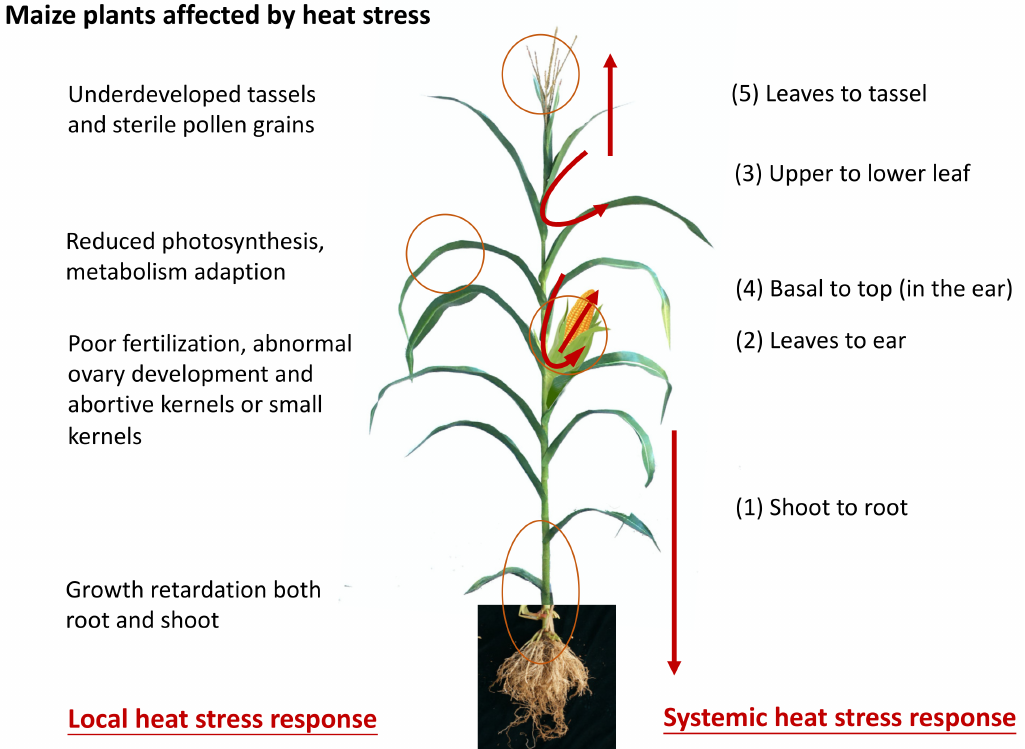
Figure 4. Schematic diagram illustrating the local and systemic level responses to heat stress. In plants, systemically acquired acclimation (SAA) is thought to be controlled by a rapid systemic signaling mechanism that maintains homeostasis during adverse en- vironmental conditions. The rapid and systemic whole-plant transmission of electric, calcium, and ROS waves is required for plant acclimation to heat, light stress, and wound responses [77–81]. ROS play a fundamental dual role in plants; they are toxic to cells, caus- ing oxidative stress, but are also important signaling molecules during a stress